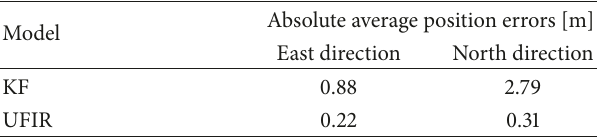
Table 3: Absolute average position errors by different filters in Test 2 (Group 2).